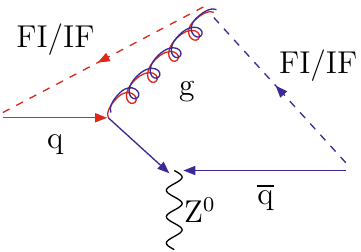
Fig. 4 Colour flow for the process q + q → γ ∗ / Z 0 + g. The dashed lines represent the colour lines stretching between the dipole ends